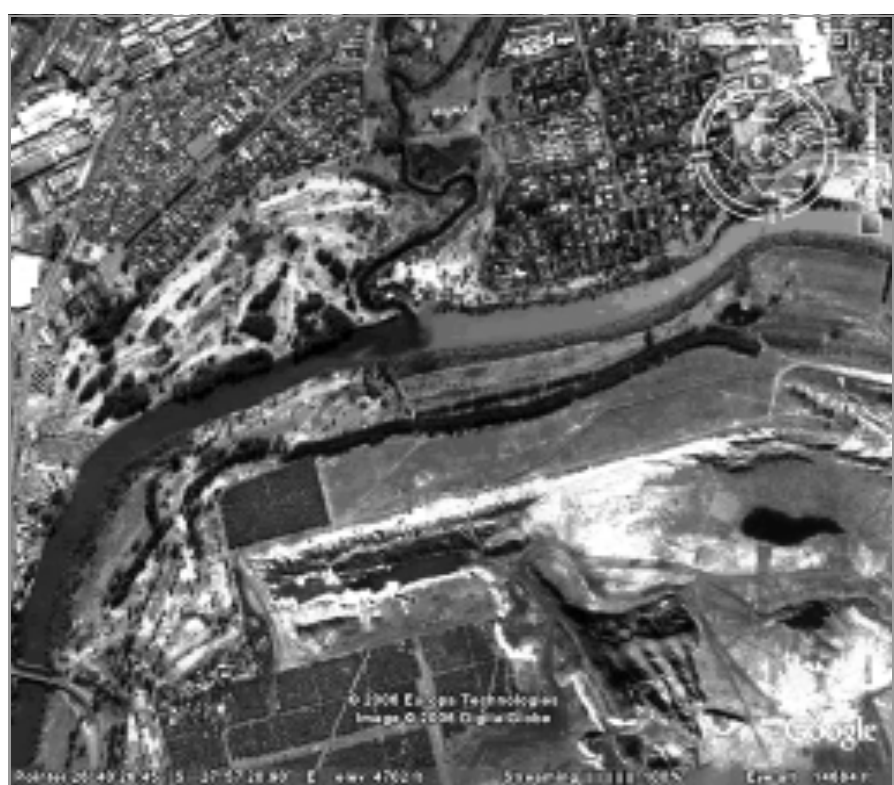
Illustration 6: Example of waste water flowing down the Klip River into the Vaal River Barrage.